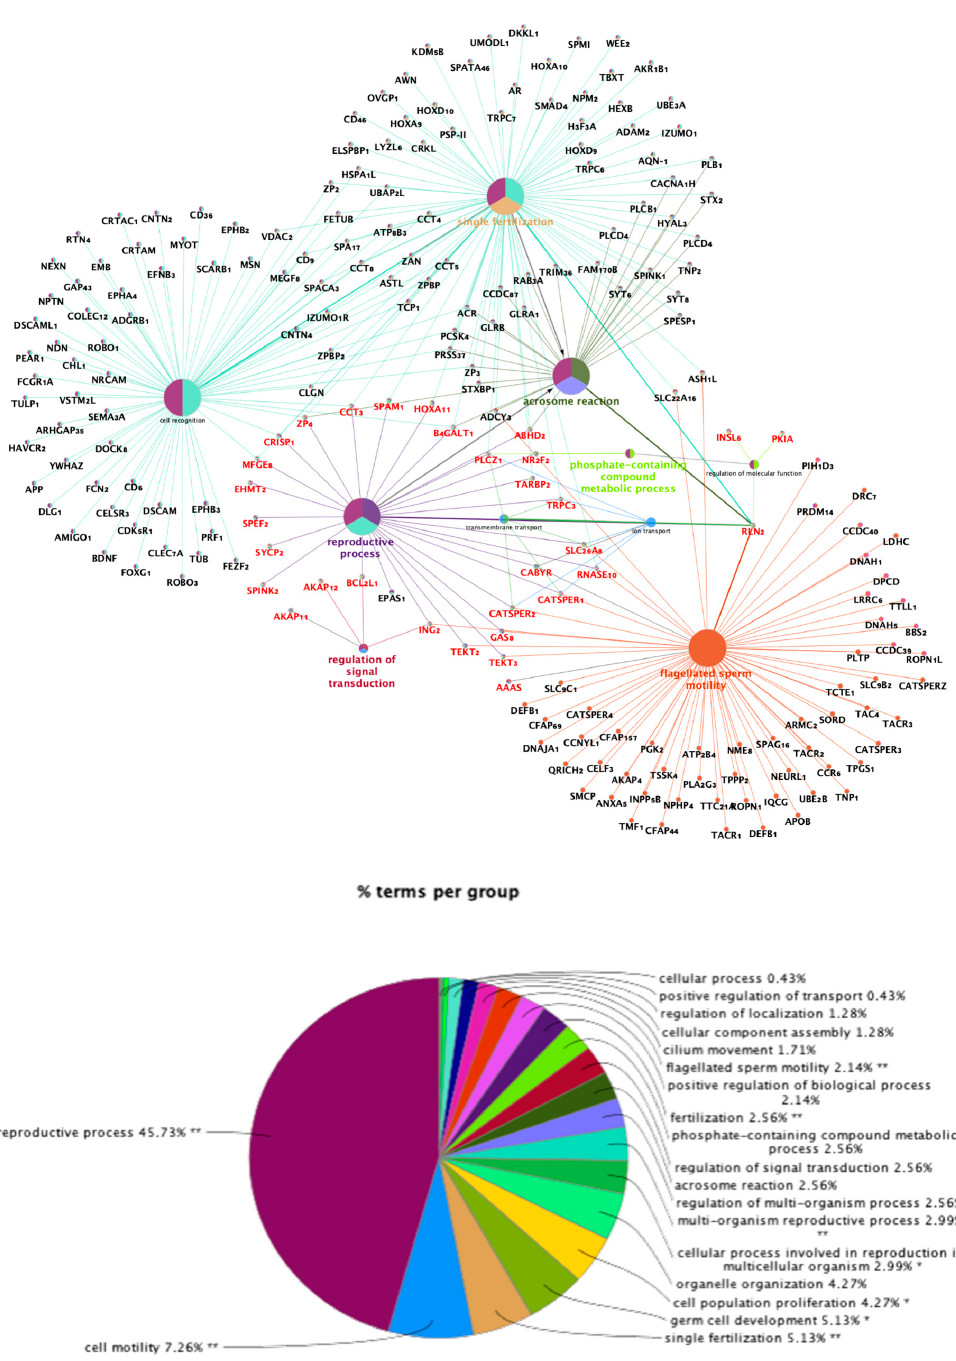
Figure 3. Schematic representation of functionally grouped terms. This network was created using the Cytoscape v3.0.0 application and the ClueGO + CluePedia (version 2.2.5) plug-in. Terms and their associated genes share the color. Genes marked in red are overrepresented in our study. The size of the nodes indicates the degree of significance, where the biggest nodes correspond to highest significance. The parameters included: biological process database (BP; date: 28.03.2019); GO tree levels, 2–6 (first level = 0); minimum number of genes, 3; minimum percentage of genes, 4; GO term fusion; GO term connection restriction (kappa score), 0.4; GO term grouping, initial group size of 2 and 50% for group merge; number of genes included in term < 100. The resulting network was modified; that is, some redundant and noninformative terms were deleted and the network manually